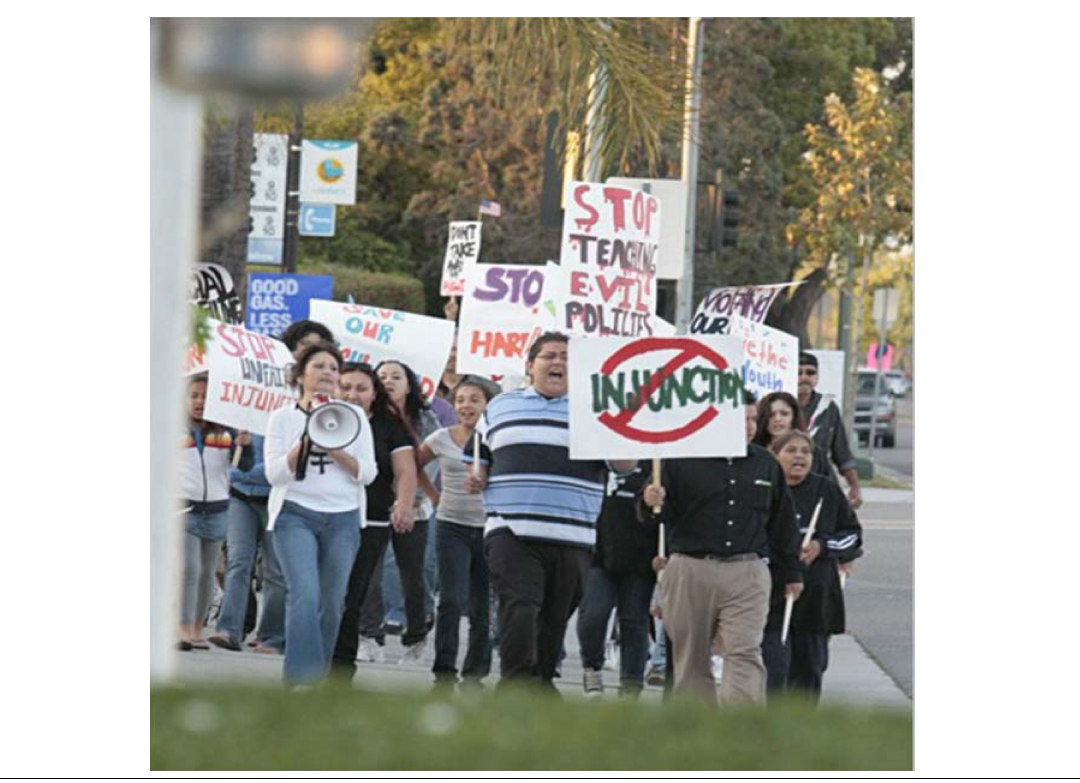
Figure 3. Elizondo (with megaphone), 25 April 2009 (Source: Keith May, courtesy of OC Weekly